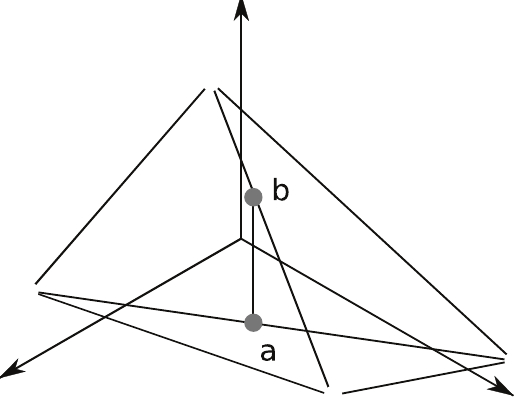
Fig. 4. Two different interpolation results dependent on the method of choosing the triangles The problem becomes even more significant when ex- trapolated, because the triangles created may have different inclinations, which sometimes leads to results that make no physical